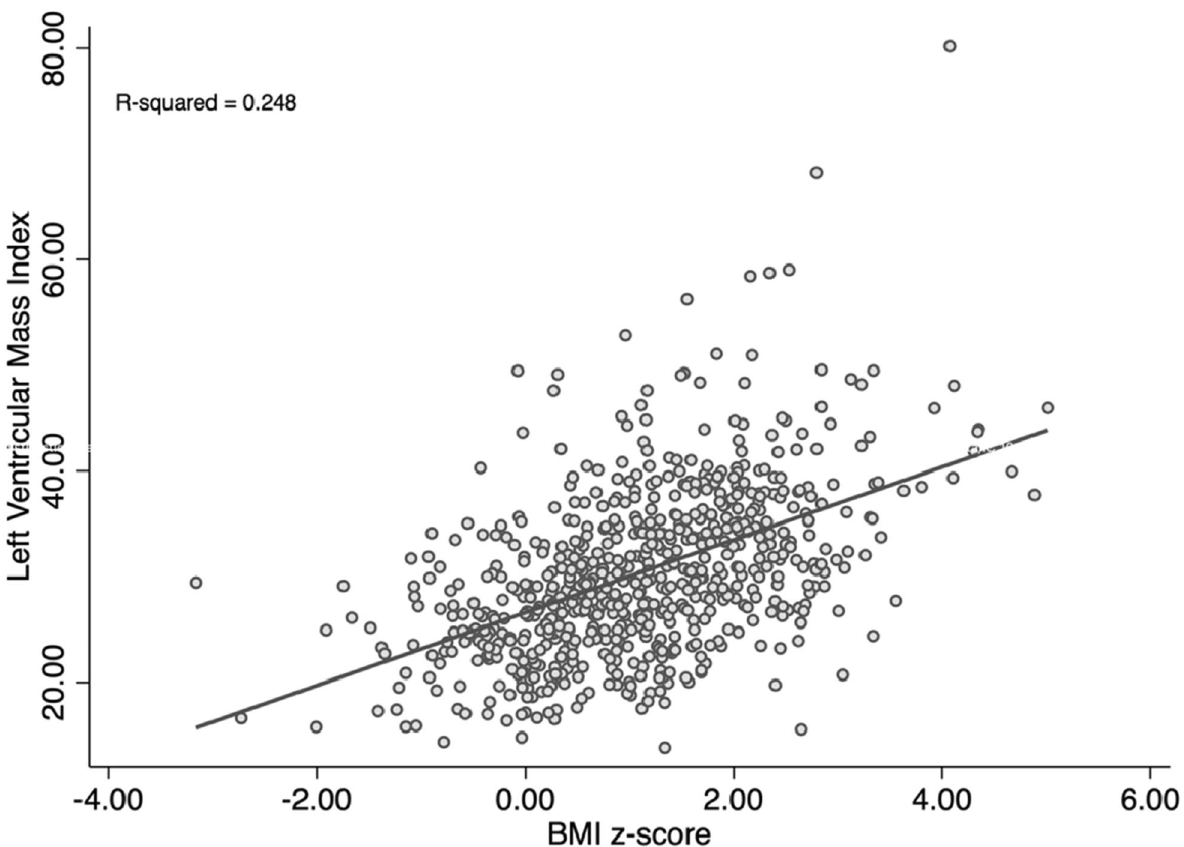
Figure 2. Relationship between left ventricular mass index and BMI z-score. The z-score of the body mass index (BMI) is shown on the x-axis. Left ventricular mass index (g/m 2.7 ) is shown on the y-axis. Each grey dot represents one child. Grey line is the linear regression line.